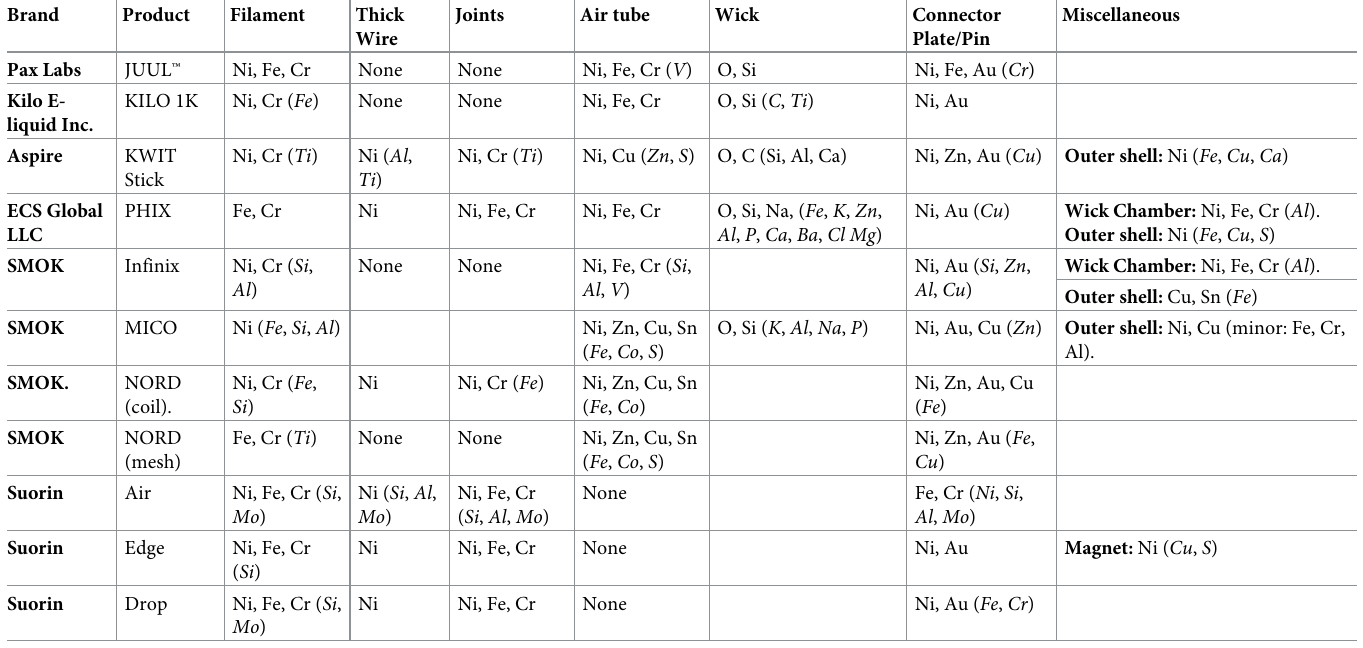
Table 1. Summary of element/metal analysis of pod EC atomizer